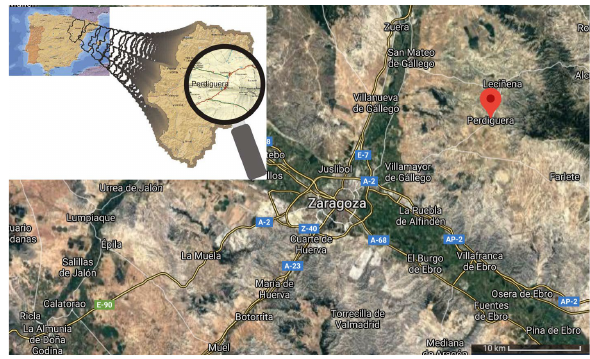
Figure 2. Location of Perdiguera.